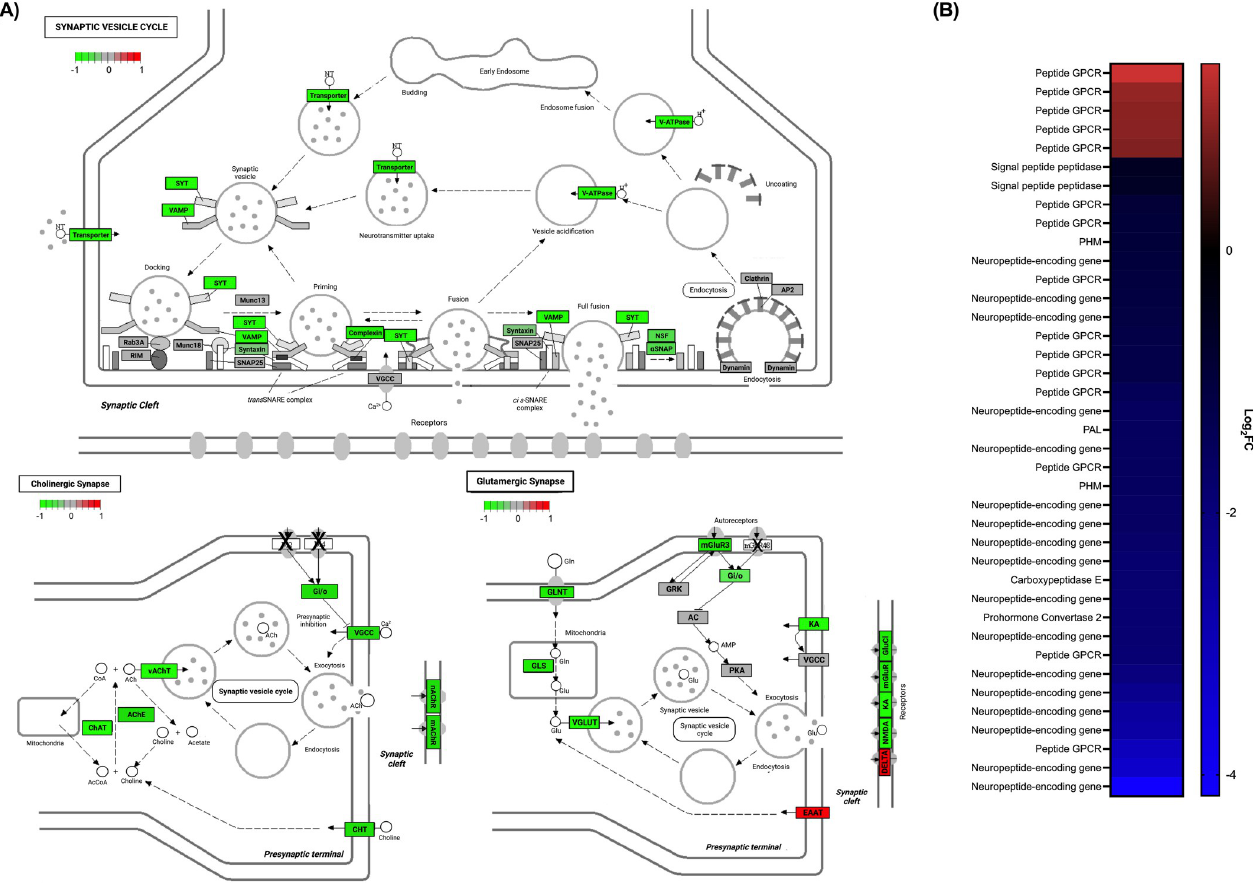
Fig 6. Key neuronal signalling pathways are downregulated in fast growing in vivo juvenile liver fluke. Components of classical neurotransmission are downregulated in in vivo maintained juvenile liver fluke (A). Differential expression of nervous system components of the synaptic vesicle cycle, cholinergic signalling and glutamatergic signalling. Fasciola hepatica homologues of human components enclosed in rectangular boxes. Green = downregulated in vivo , red = upregulated in vivo , grey = not differentially expressed, X = not present in F . hepatica genome (PRJEB25283). Abbreviations: SYT, synaptotagmin; VAMP, vesicle associated membrane protein; Rab3a, ras-related protein; RIM, regulating synaptic membrane exocytosis protein; MUNC(-13, -18), syntaxin binding protein; SNAP25, synaptosome associated protein; VGCC, voltage-gated calcium channel; NSF, N-ethylmaleimide sensitive factor; α SNAP, NSF associated protein; AP2, adaptor related protein complex 2; ChAT, choline O-acetyltransferase; AChE, acetylcholinesterase; vAChT, vesicular acetylcholine transporter; CHT, high affinity choline transporter; Gi/o, guanine nucleotide-binding protein; mAChR, muscarinic acetylcholine receptor; nAChR, nicotinic acetylcholine receptor; GLNT, amino acid transporter; GLS, glutaminase; vGLUT, vesicular glutamate transporter; GRK, G protein-coupled receptor kinase; AC, adenylate cyclase 1; PKA, protein kinase A; EAAT, glial high affinity glutamate transporter; mGluR, muscarinic glutamate receptor; GluCl, glutamate- gated chloride channel; KA, kainate type ionotropic glutamate receptor; NMDA, NMDA type ionotropic glutamate receptor; DELTA, delta type ionotropic glutamate receptor. Components of neuropeptidergic signalling pathway are downregulated in in vivo juvenile liver fluke (B). Heatmap showing differentially expressed genes associated with neuropeptidergic signalling in Fasciola hepatica .